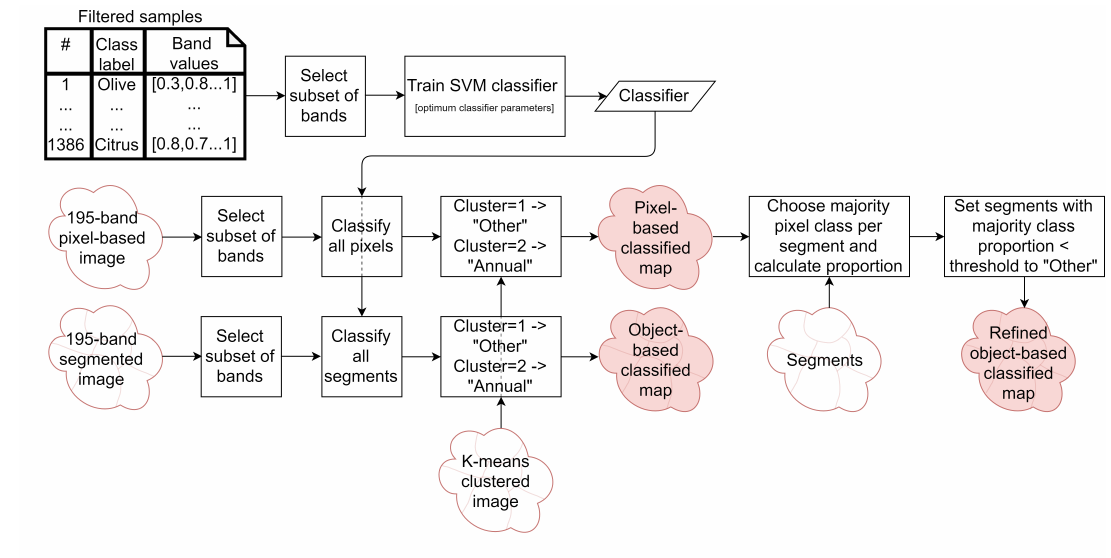
Figure 8. Method of generating pixel-based, object-based and refined object-based